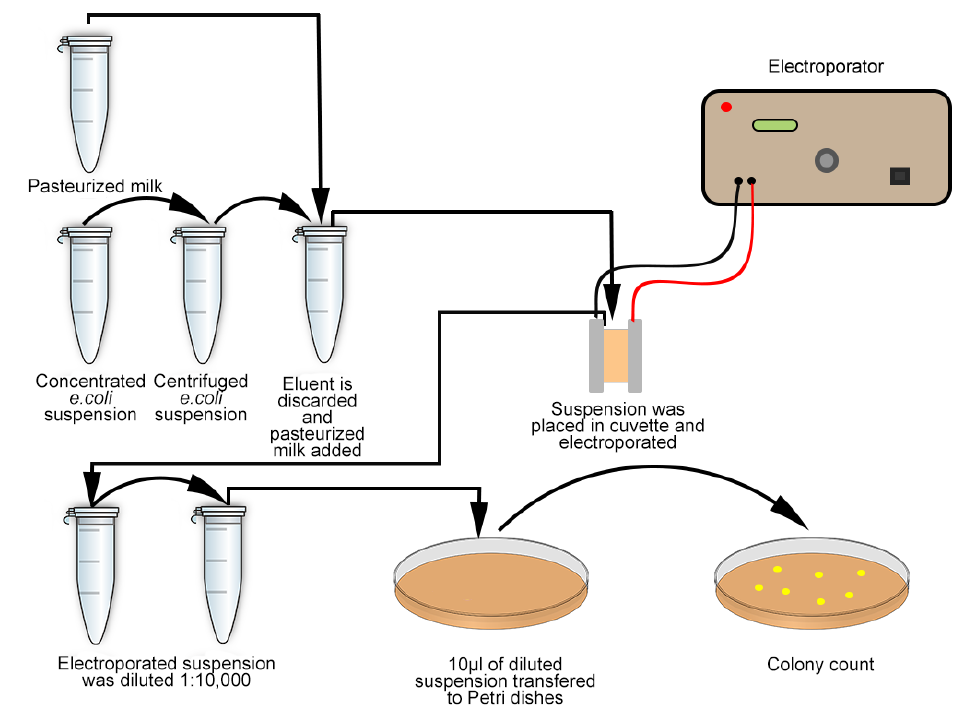
Figure 1. Schematics of an experiment to determine the most effective PEF parameters for bacterial inactivation in milk samples.